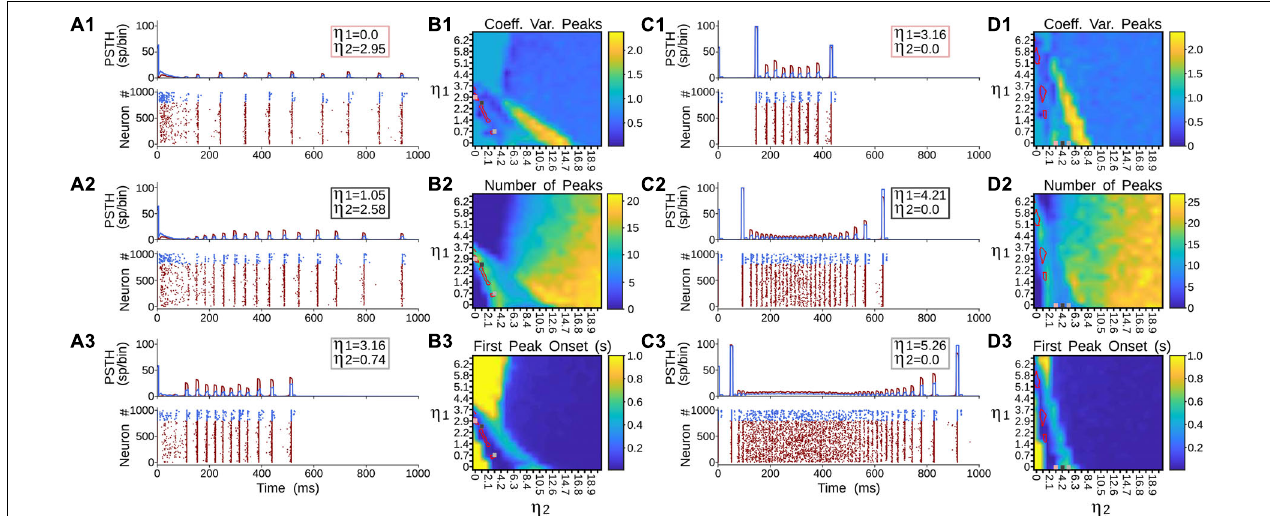
FIGURE 7 | Terminal types 1 and 2 produce different activation dynamics in the thalamic network at the beginning of the stimulation. (A) PSTH and raster plots for area 17 solutions. (B) Outcomes of such solutions for (1) coefficient of variation of alpha waves peaks, (2) number of peaks per second, and (3) first peak onset. (C) PSTH and raster plots for area 21a solutions. (D) Outcomes of such solutions for (1) coefficient of variation of alpha waves peaks, (2) number of peaks per second, and (3) first peak